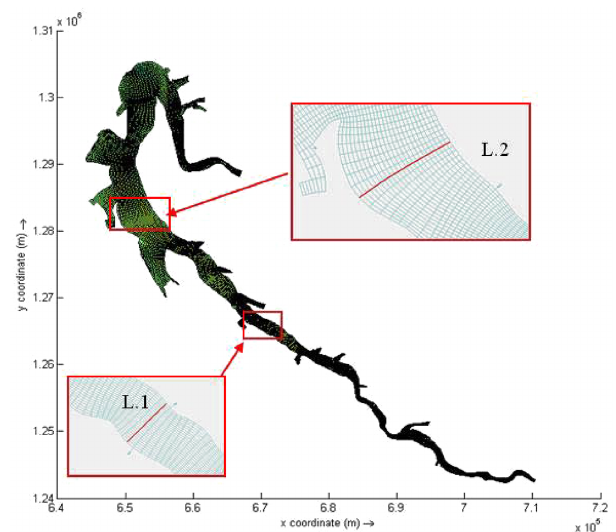
Figure 11. Selected coring areas (L1 and